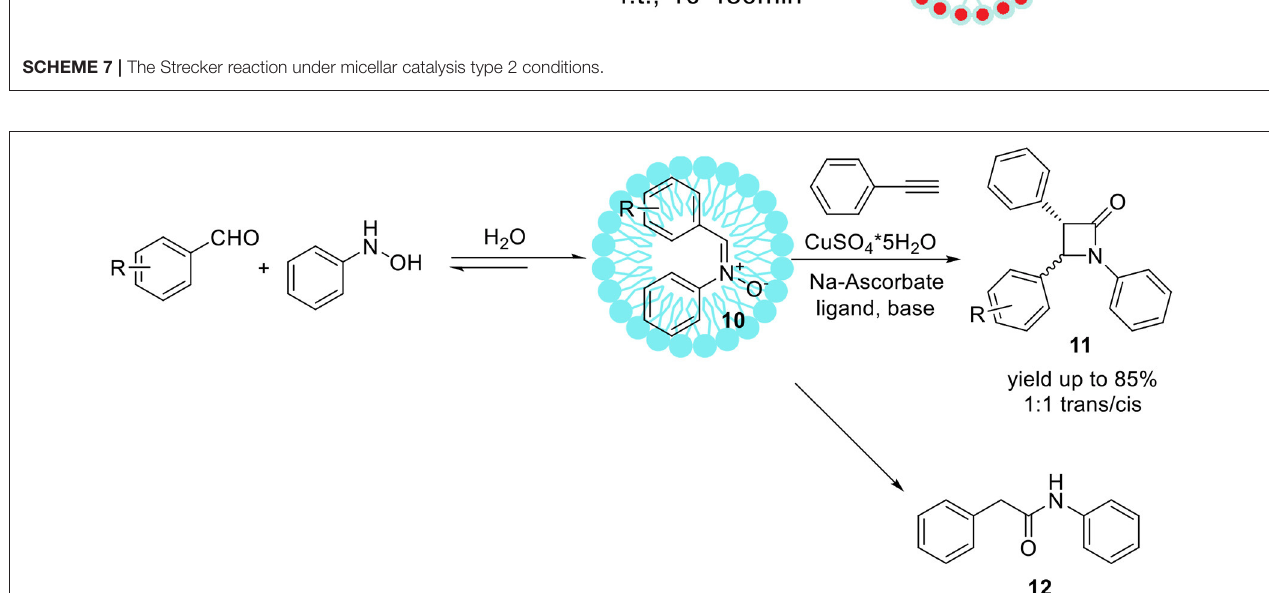
SCHEME 8 | Micelles promoted synthesis of β -lactames via Kinugasa